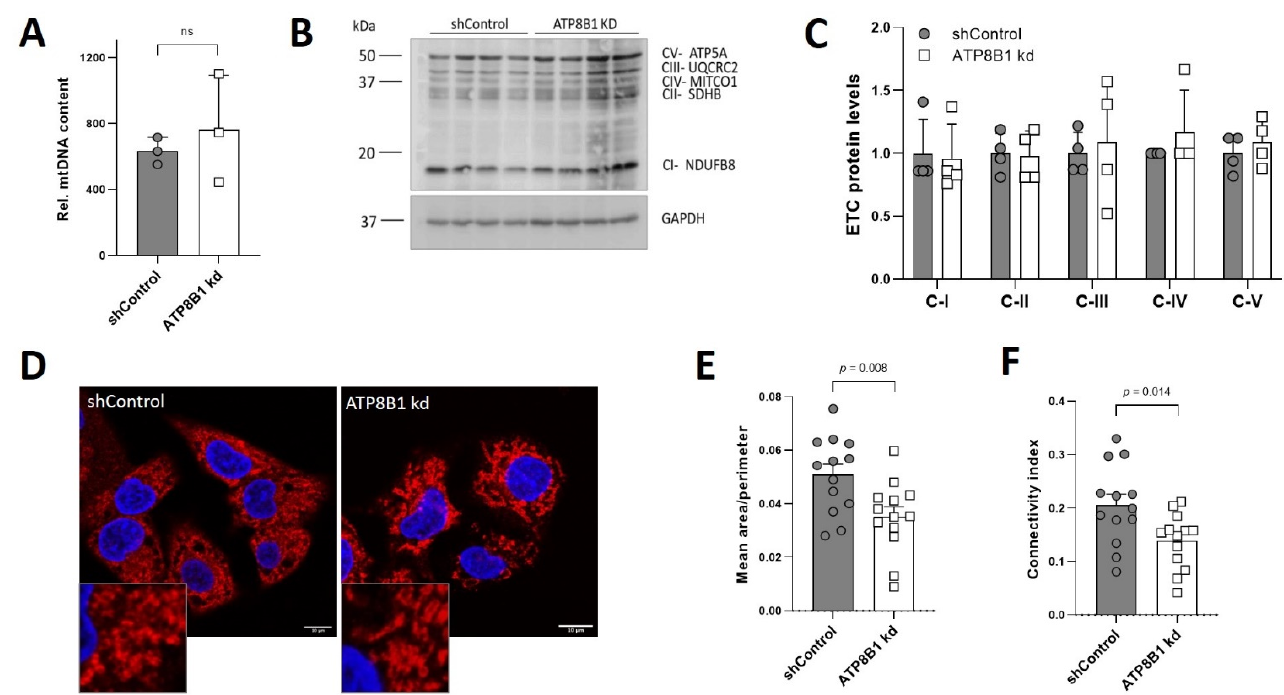
Figure 4. No change in mitochondrial mass and increased mitochondrial fragmentation in ATP8B1 knockdown cells. ( A ) Genomic LC-PCR analysis of the mtDNA NADH-ubiquinone oxidoreductase chain 1. Data are expressed as mean +/ − s.d. of 3 independent DNA isolations. Statistical analysis by an unpaired t -test; ns, not significant; ( B ) Western blot analysis from total cell lysates of electron transport chain complex (ETC) I-V protein markers; ( C ) Densitometric analysis of ETC protein levels. Data were corrected for GAPDH, normalized to shControl cells and expressed as means +/ − s.d. of 4 independent experiments. No statistical significance by multiple unpaired t -test; ( D ) Confocal analysis of TOM20 staining in red and nuclear dapi in blue. Bar = 10 nm; ( E , F ) Quantification of mitochondrial fragmentation. HepG2 cells were stained for TOM20 and the mitochondrial network was quantified as described in the materials and methods. Ratio of mean mitochondrial area over perimeter ( E ) and mitochondrial connectivity ( F ), representing average mitochondrial area/perimeter ratio normalized to circularity to account for mitochondrial swelling, are shown. Data are expressed mean values +/ − s.e.m. of 13 images (3–4 cells/image) from 3 independent experiments. Statistical analysis by an unpaired t -test.